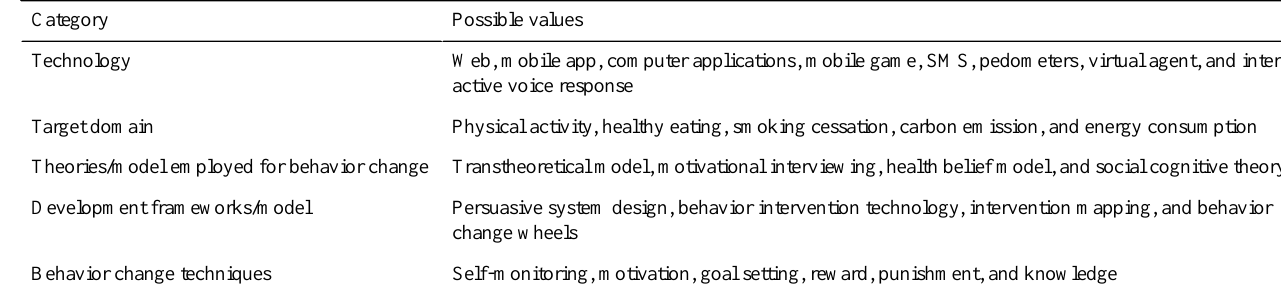
Table 1. Classification and coding scheme.